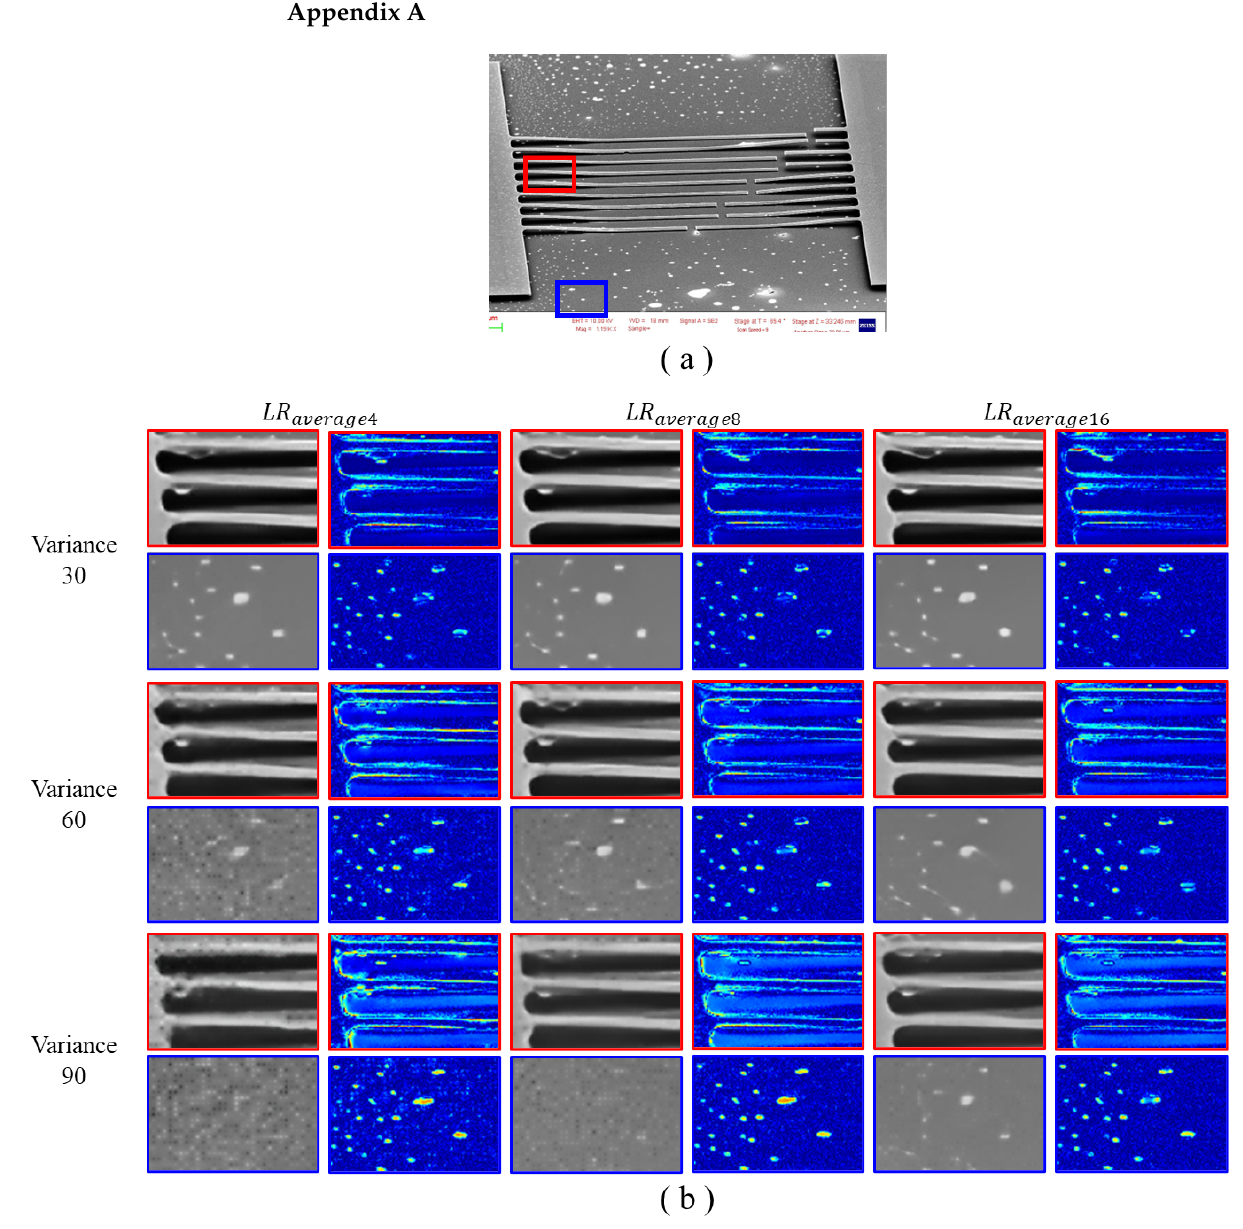
Figure A1. Qualitative comparison of our proposed scheme for different noise levels and different numbers of averaged images during denoising: ( a ) full-resolution image is the HR target image, which is given as a reference for the positions of the magnified boxes; ( b ) magnified images and error map illustrated in the heat map for reference ( a ). Images are evaluated for different noise levels (variances of 30, 60, and 90) and different numbers of averaged images for denoising (4, 8, and 16 images used). The red and blue boxes show the magnified SR results and the error map trained for each setting for LR average images at each noise level. The error map is illustrated as a heat map, with the error between the SR and target HR images amplified five times for visual comparison. The baseline network chosen is